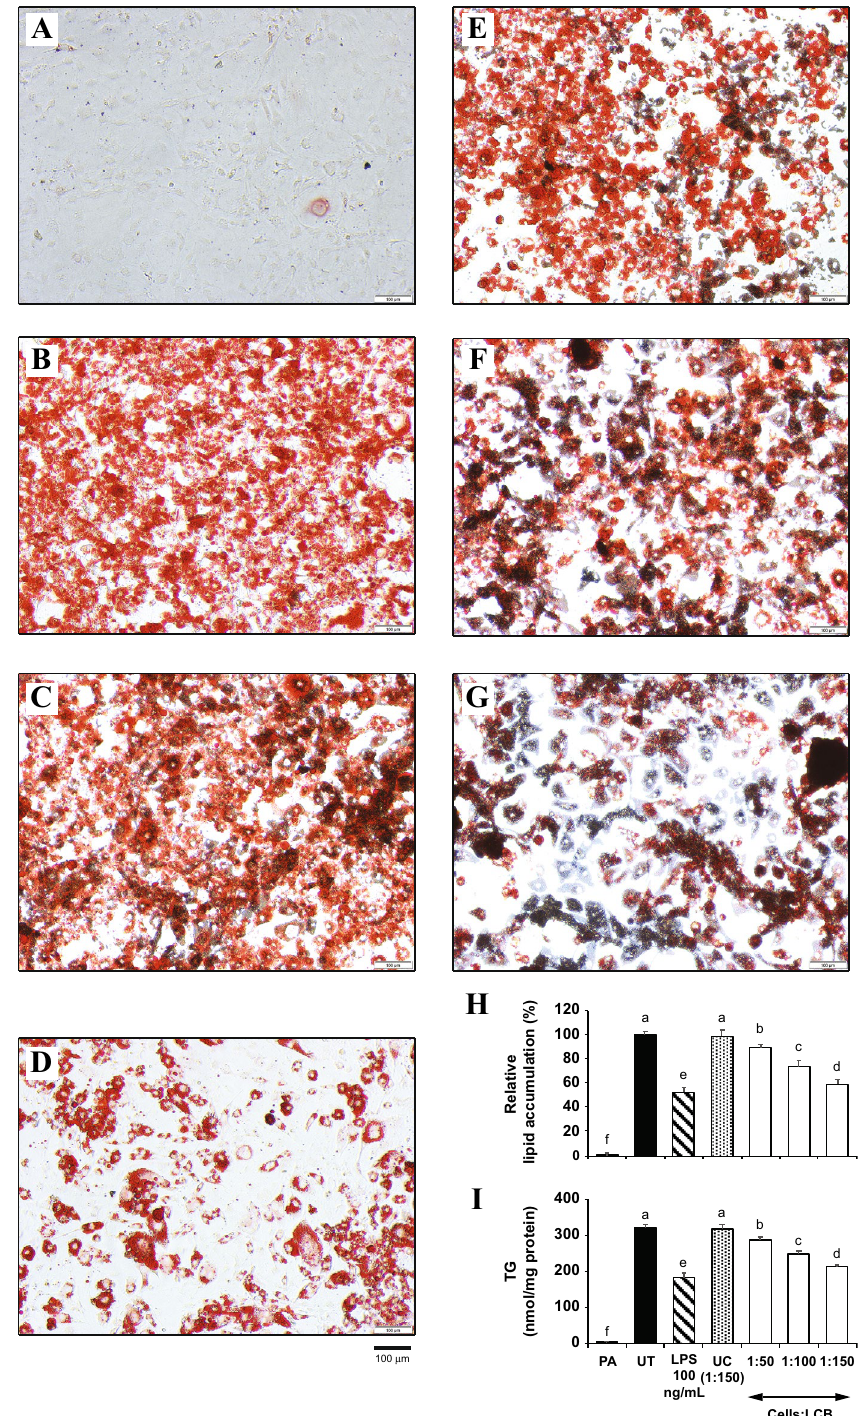
Figure 1. LCB inhibits adipogenesis in a dose-dependent manner. Preadipocytes (A) , fully differentiated adipocytes (B) , differentiating adipocytes treated with uncoated beads (1:150 cells:UC) (C) , 100 ng/mL LPS (D) , and an increasing amount of LCB (1:50, 1:100, and 1:150 cells:LCB ratios in E–G ) were stained with Oil Red O dye, which binds to triglycerides in the cells. LPS, a known adipogenic inhibitor, and LCB were added to the cells from the beginning of differentiation and maintained throughout adipogenesis. (H) shows the spectrophotometric absorbance at 520 nm for the Oil Red O dye that binds to triglycerides in the cells. The results are presented as the relative lipid accumulation percentages in respect to the PA set. (I) shows the quantitative measurement of the total triglycerides in the cells using the total triglyceride assay. PA, UT, and UC are abbreviated for preadipocytes, untreated, and uncoated beads,